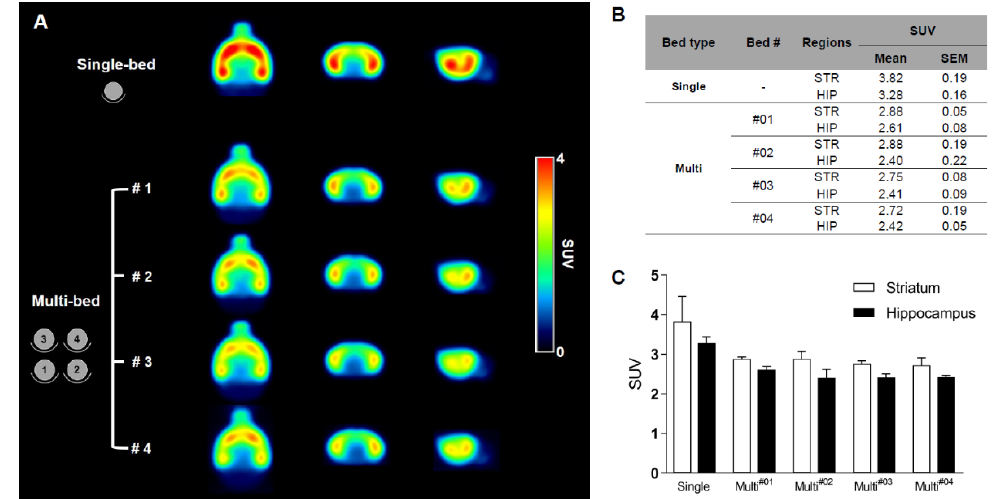
Figure 4. Summed 18 F-FPEB brain PET images of the single-bed (n = 12) and each bed of the multi-bed system ( A , n = 3 in each bed). Comparison of regional SUV values of single- and multi-bed systems ( B , C ). STR, striatum; HIP, hippocampus; SUV, standardized uptake value.